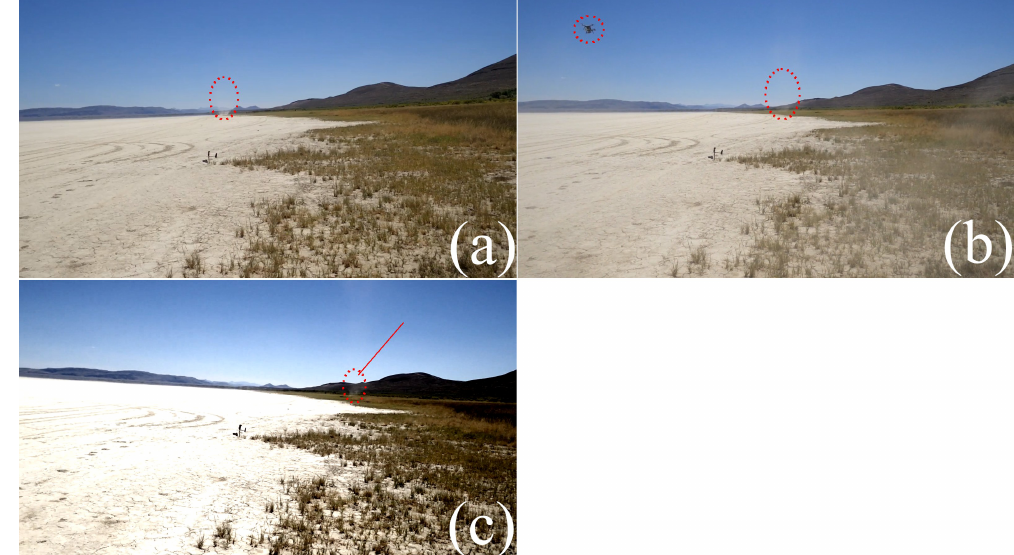
Figure 5. Stills from the video collected by the left camera in the stereogrammetry set-up during Flight 1. ( a ) the first (and only) dust devil appears at a distance of about 80 m, approximately 20 s before launch (at timestamp 0:00); ( b ) the drone appears in frame and heads toward the dust devil, approximately 3 s after launch (at timestamp 0:23); ( c ) contrast-enhanced still of the approximate moment of encounter, when the lateral position of the drone (indicated by the red line) appears to coincide with the dust devil’s center, approximately 18 s after launch (at timestamp 0:38). An anemometer appears near the center of each